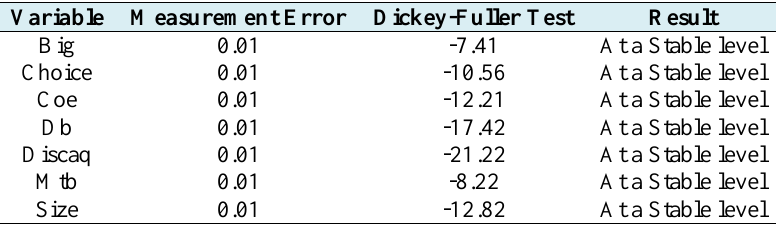
Table 1. Unit Root Test by Dickey-Fuller Test